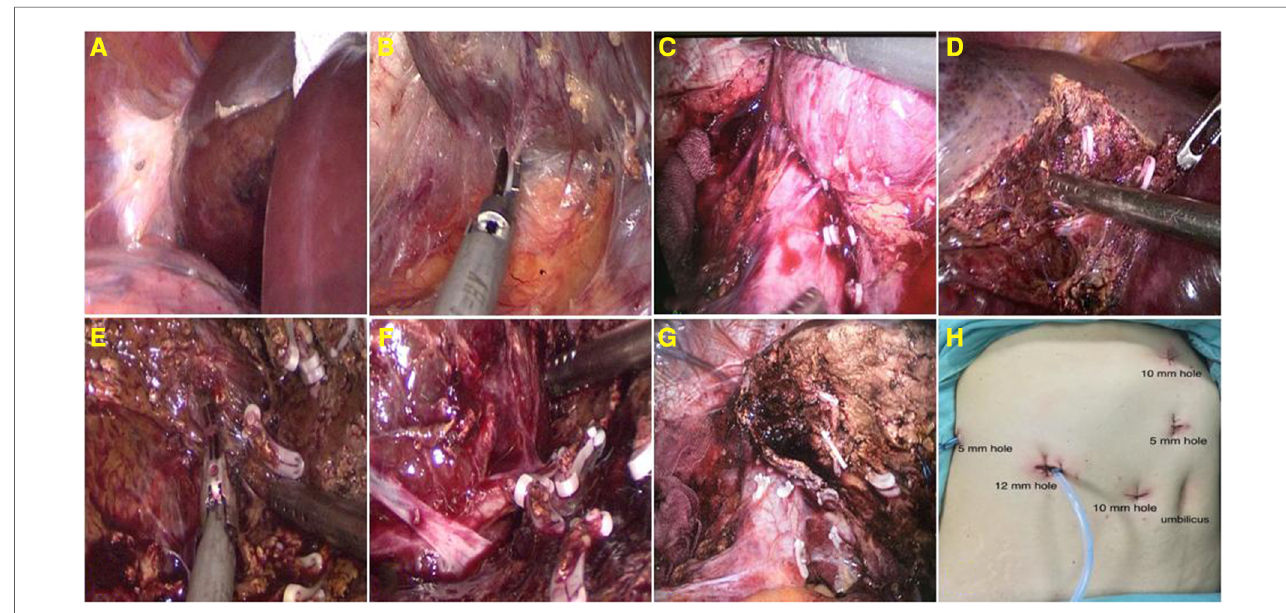
FIGURE 2 Expose and detach the right triangular ligament ( A ); detach the liver ’ s bare area and retrohepatic space ( B ); segregate and amputate the short hepatic vein at the third hepatic portal ( C ); stripping the hemangioma with aspirator and ultrasonic knife ( D – F ); the liver transection surface ( G ); and layout of trocars ( H ).